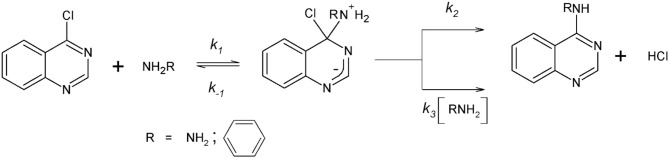
General reaction mechanism for the SNAr of 4-chloroquinazoline and the amines studied.